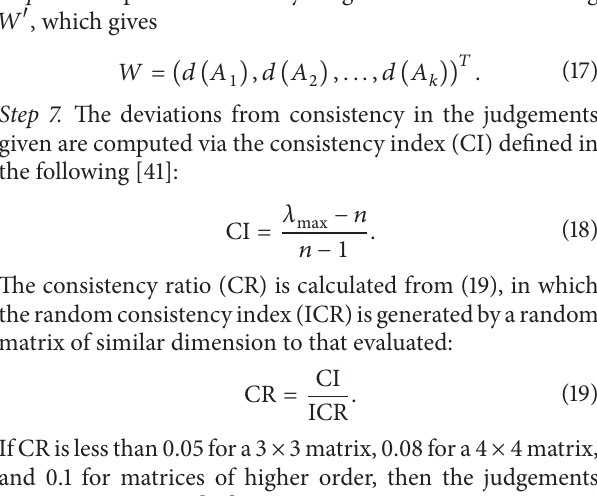
Figure 1: The intersection between